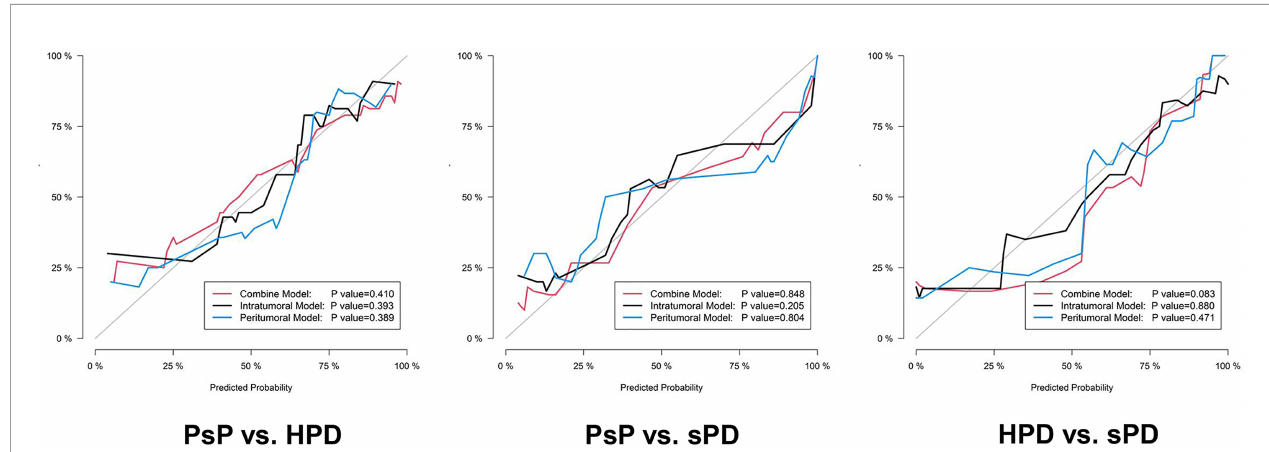
FIGURE 5 | The calibration curves of the proposed radiomics models in the testing datasets. The 45° gray line indicates an ideal prediction. The black, blue, and red lines represent the intratumoral, peritumoral, and combined model predicted results, respectively. The X axis represents the predicted probability, and the Y axis represents true probability. The p value was derived from the Hosmer – Lemeshow test.